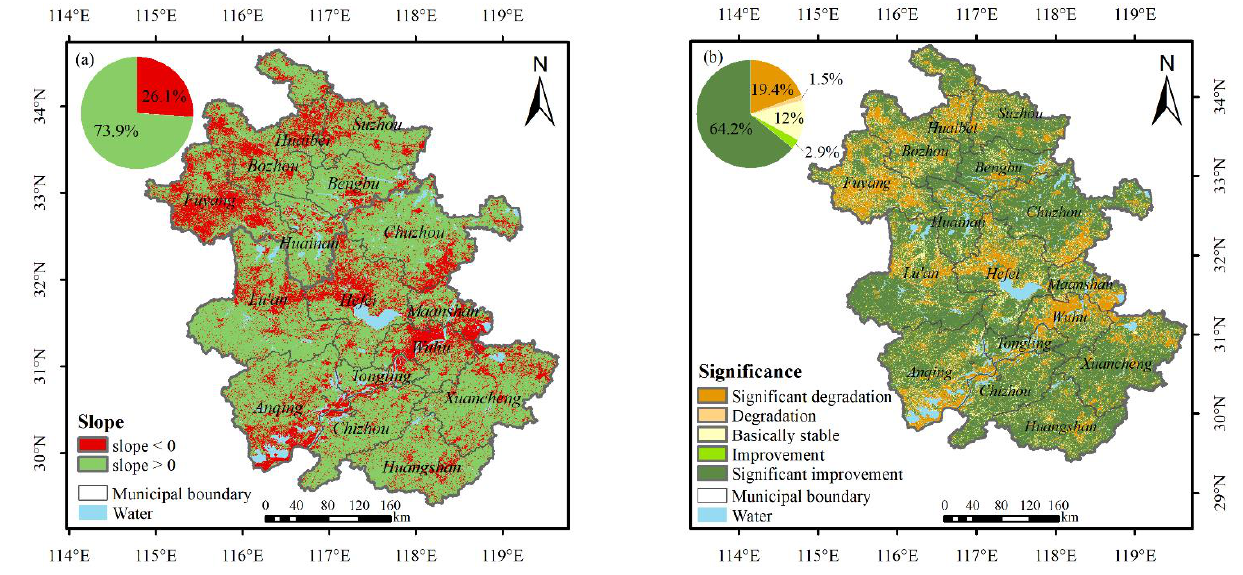
Figure 5. Spatial distribution of changes in EVI in Anhui Province during 2000 – 2020. ( a ) Slope of variation in EVI. ( b ) Spatial variation trend of EVI.